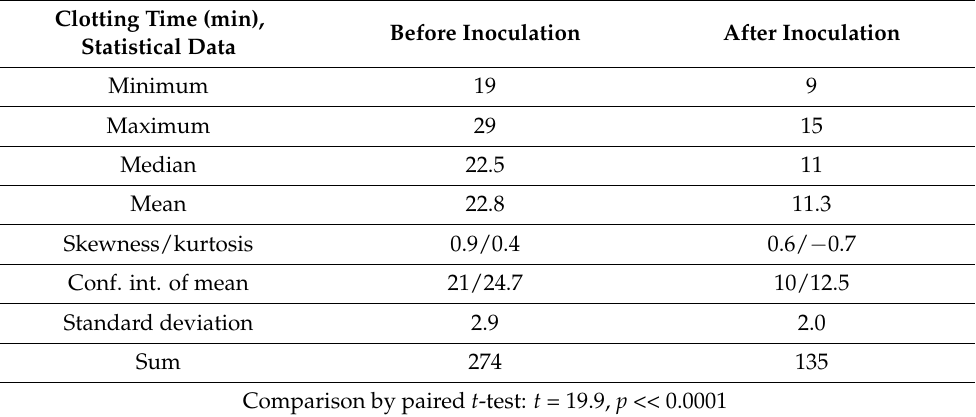
Table 3. Observation of the clotting time (min) of * mix 2 to evaluate the interference capacity against ** VSA of the sera of group A sheep before and after administration of vampire bat saliva–incomplete Freund’s